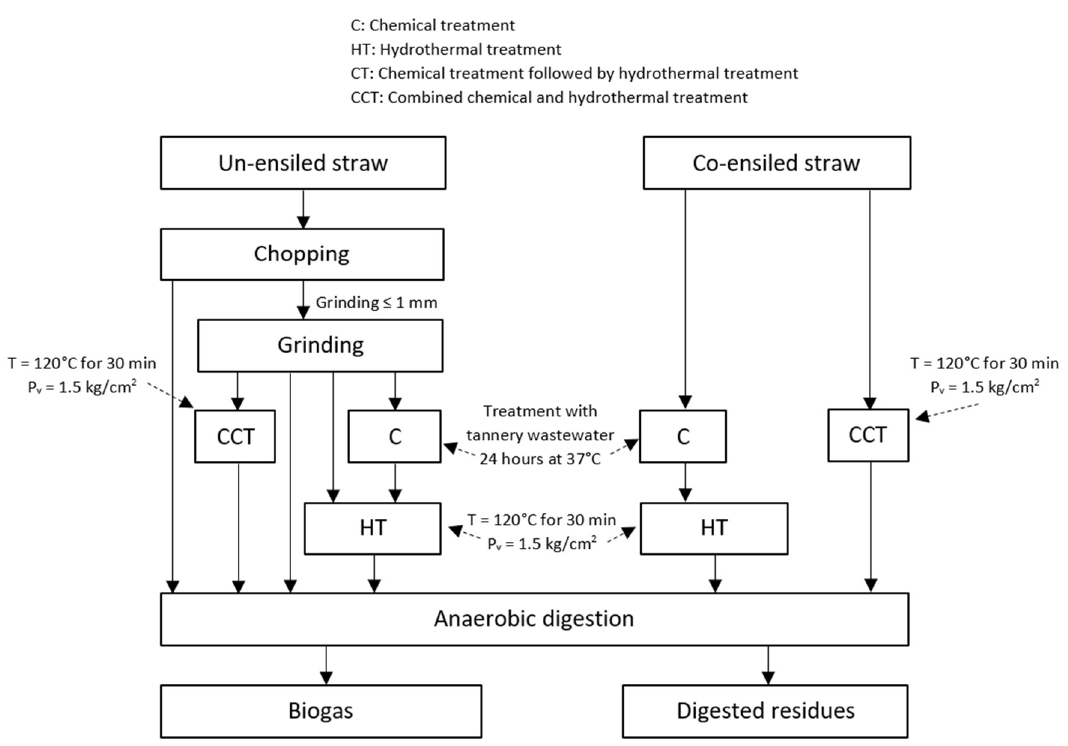
Figure 1. Schematic overview of pre-treatment procedures.